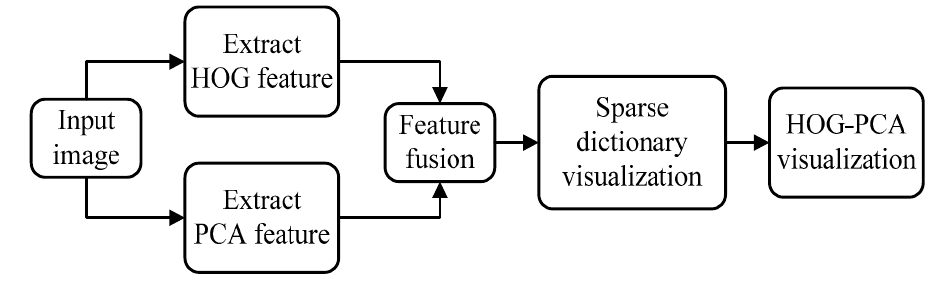
Figure 2. Flowchart of our proposed algorithm.